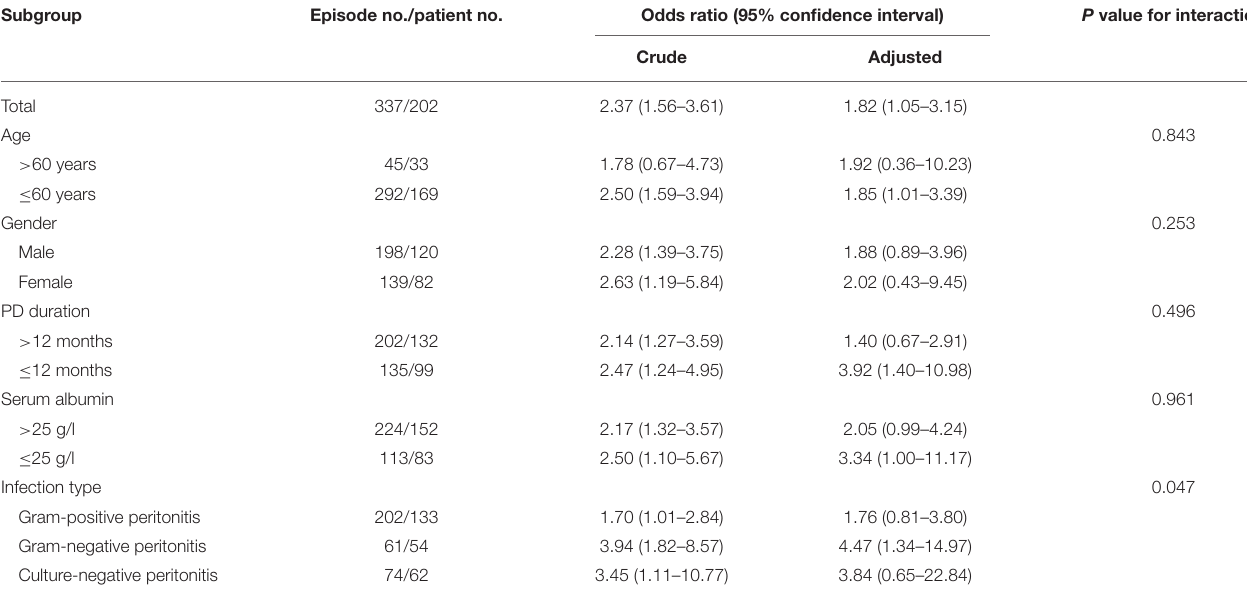
TABLE 4 | Subgroup analyses of the association between NLR and treatment